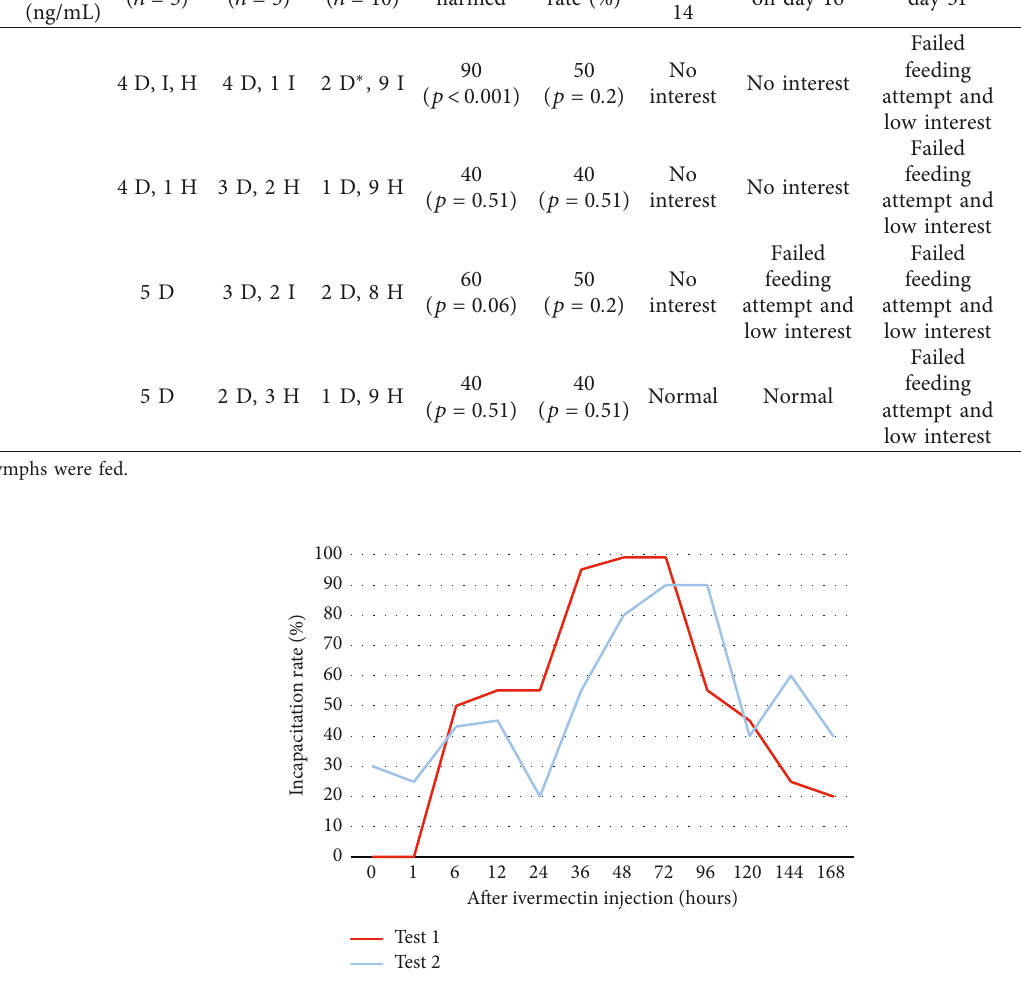
Figure 1: Bed bug incapacitation rates after feeding on a rabbit injected with 0.3mg/kg of ivermectin (Test 1 and Test 2).